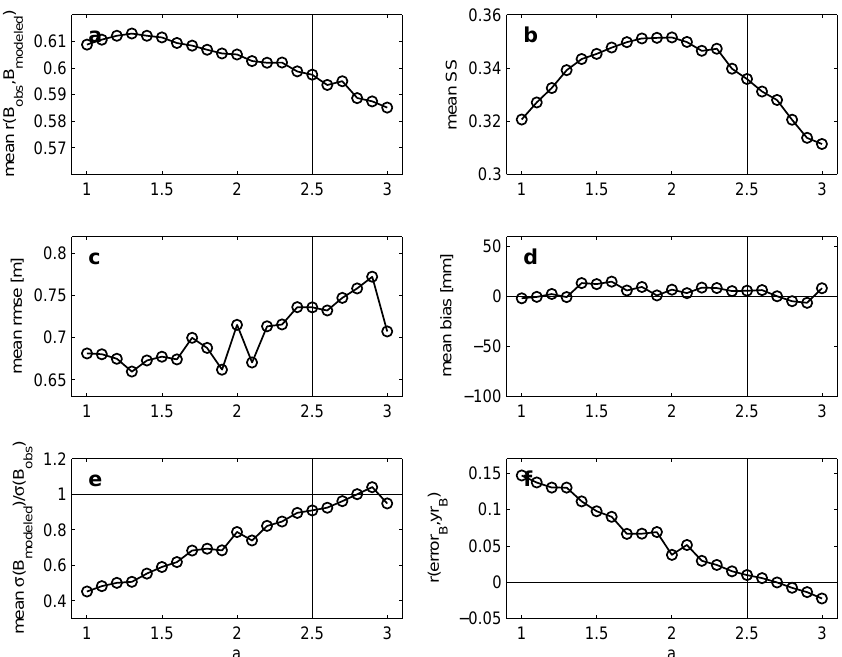
Fig. 4. Results of the cross-validation for varying the precipitation correction a . (a) mean correlation between observed and modeled mass balances; (b) mean skill score; (c) mean rmse; (d) mean model bias; (e) mean quotient of the standard deviations of modeled and observed mass balances; (f) correlation between error and year of the modeled mass balances; vertical lines indicate the finally chosen parameter value; the other three global parameters (see Sect. 2.2) are set to the values indicated by vertical lines in the following three